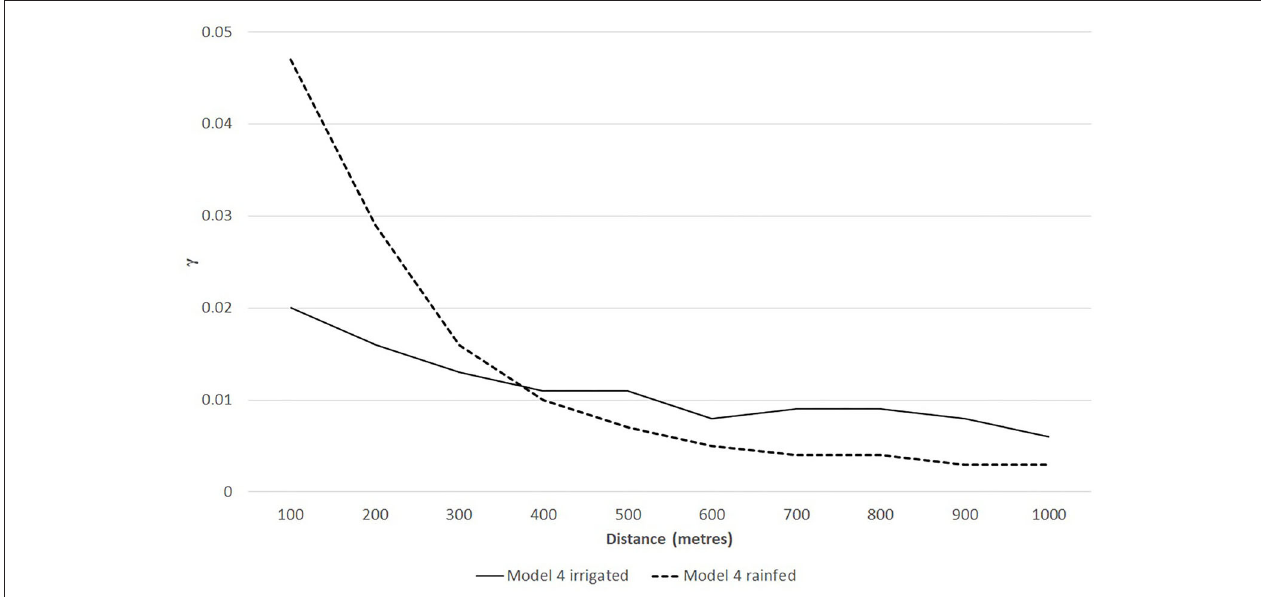
FIGURE 3 | Spatial dependence in the output (γ) at different cut-off distances for model 4 in irrigated farms and rainfed farms.